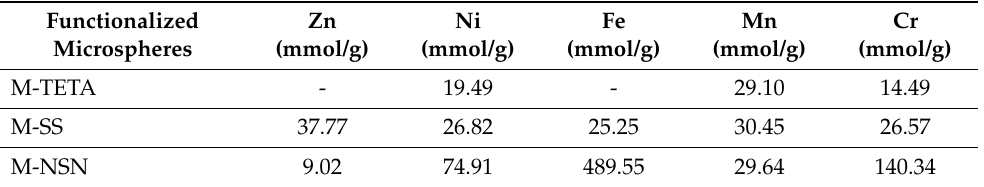
Figure 9. Base metals adsorption/elution profiles using 5 mL of 1 M leachate solution on 0.3 g functionalized Merrifield resins: ( A ) M-TETA, ( B ) M-SS and ( C ) M-NSN were, respectively, washed with 1 M HCl and eluted with 3% w/v thiourea at ambient temperature. Table 3. Loading capacities of base metals extracted using microspheres beads functionalized M-TETA, M-SS, and M-NSN.